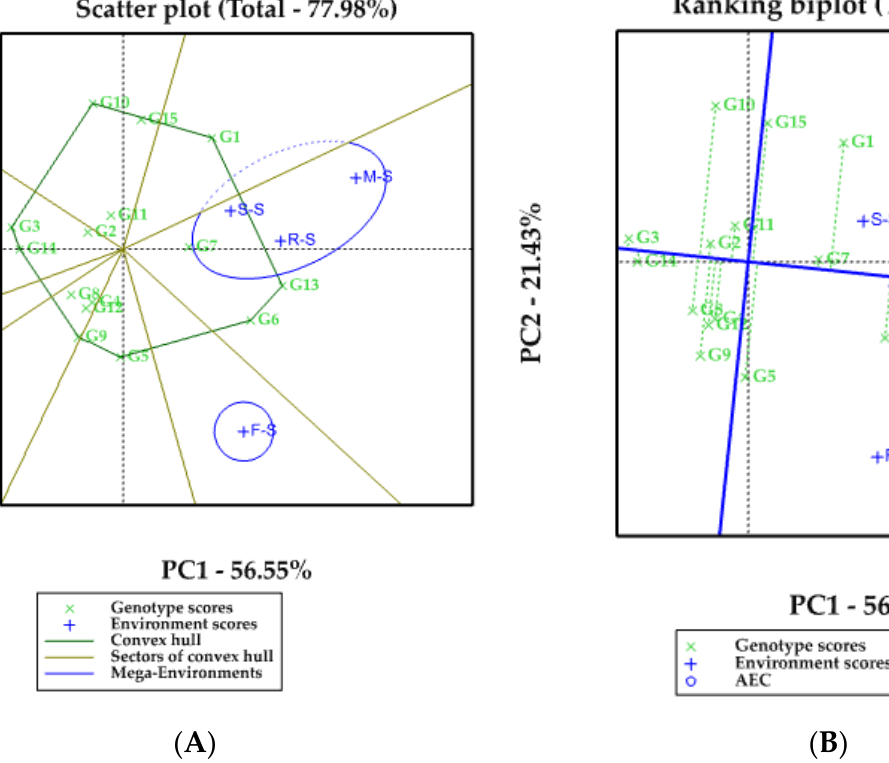
Figure 3. Soybean crop rotation stability during the wet season. ( A ) GGE biplot polygon with which-won-where pattern; ( B ) AEC shows the GGE biplot based on environmental scaling of the mean value and stability of genotype; ( C ) GGE biplot based on genotype-focused scaling to compare genotypes with the ideal genotype. G1: Anjasmoro; G2: Argomulyo; G3: Baluran; G4: Biosoy I; G5: Burangrang; G6: Dega I; G7: Dena I; G8: Dena II; G9: Dering I; G10: Dering II; G11: Dering III; G12: Devon I; G13: Grobogan; G14: Mahameru; G15: Tanggamus. F–S: Soybean planting after fallow; R–M: Soybean planting after maize; R–S: Soybean planting after rice; S–S: continuous soybean.